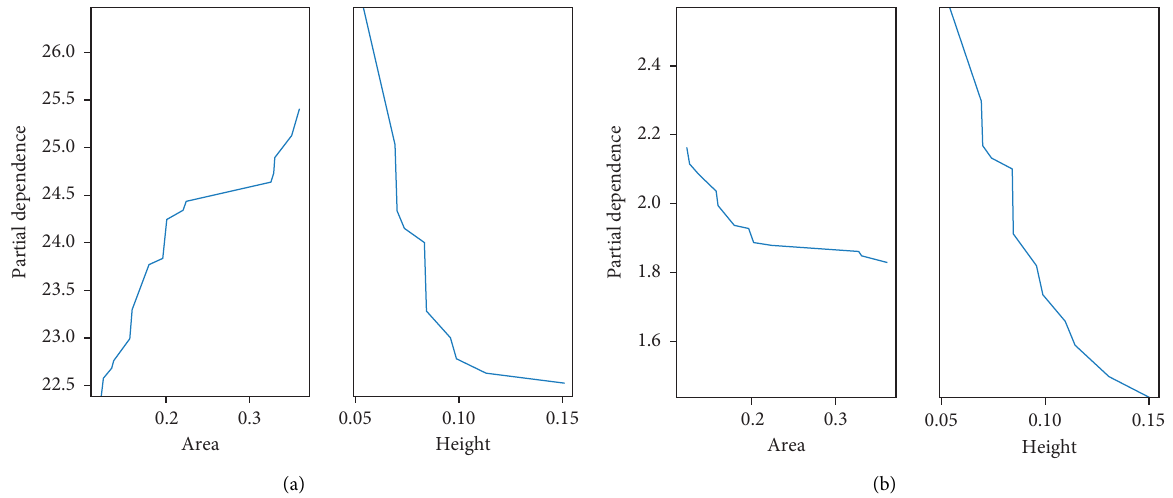
Figure 13: The partial dependence of sectional area ( A ) and bearing height ( H ) with (a) pier’s top displacement and (b) bearing ESS. 25.0